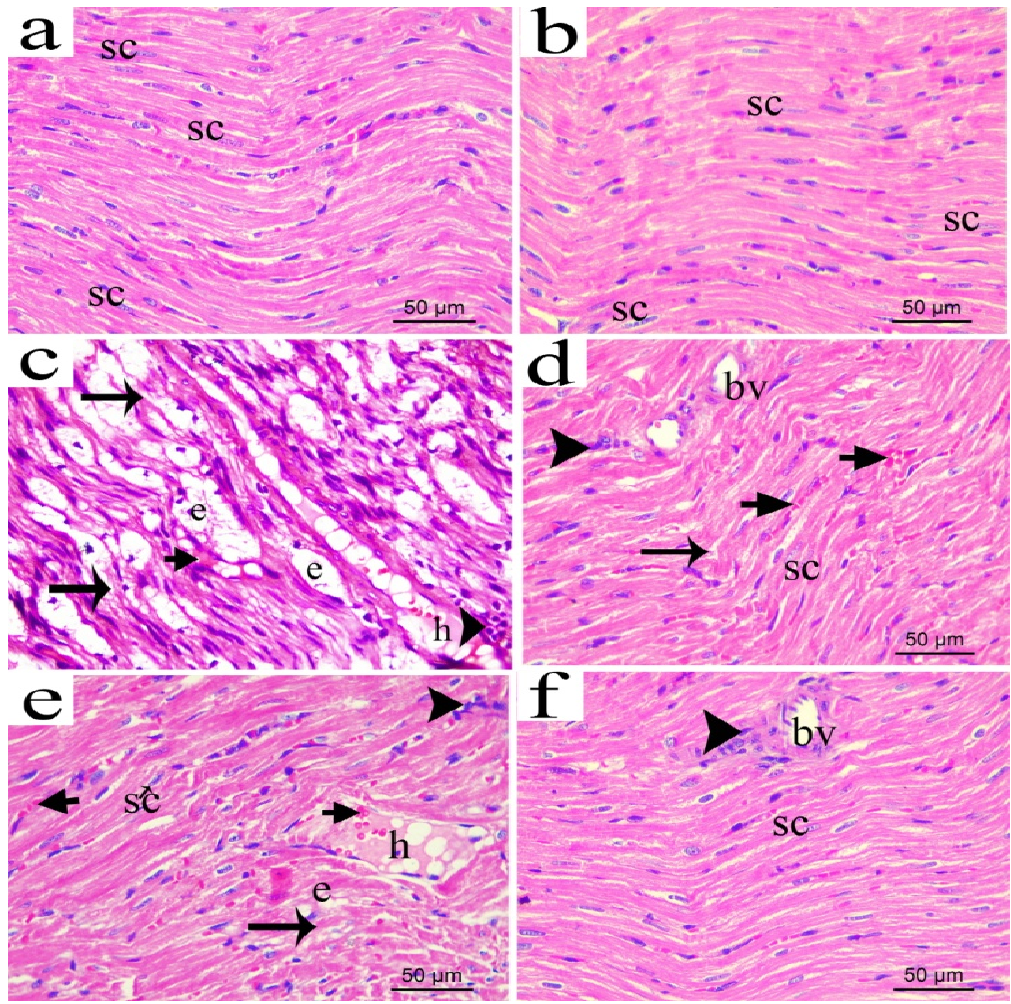
Figure 14. Photomicrograph (H&E × 400) of longitudinal sciatic nerve sections from: normal ( a ); sham ( b ); CCI ( c ); pregabalin ( d ); H. campechianum flower extract (200 mg/kg); ( e ); H. campechianum flower extract (400 mg/kg) ( f ) rats. Rats received different treatments for 14 days after which the animals were sacrificed, and tissues were collected. Arrow and arrowheads illustrate myelin sheets degeneration and mononuclear infiltrating cells, respectively. bv, blood vessel; E, exudate; hg, hemorrhage; S, Schwan cell nuclei. Scale bar, 50 μm.